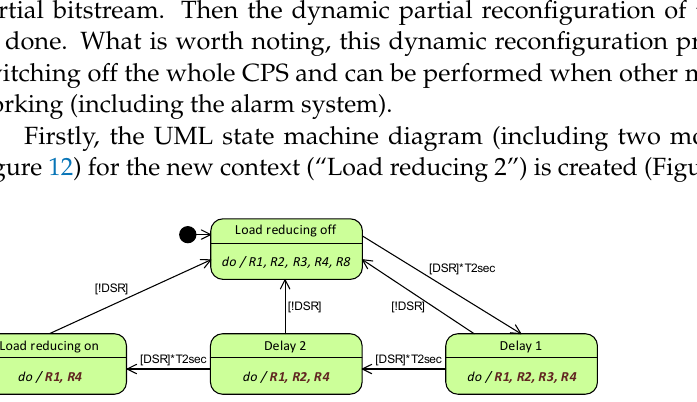
Figure 17. SHS—a UML state machine diagram for the new version of the load-reducing module.